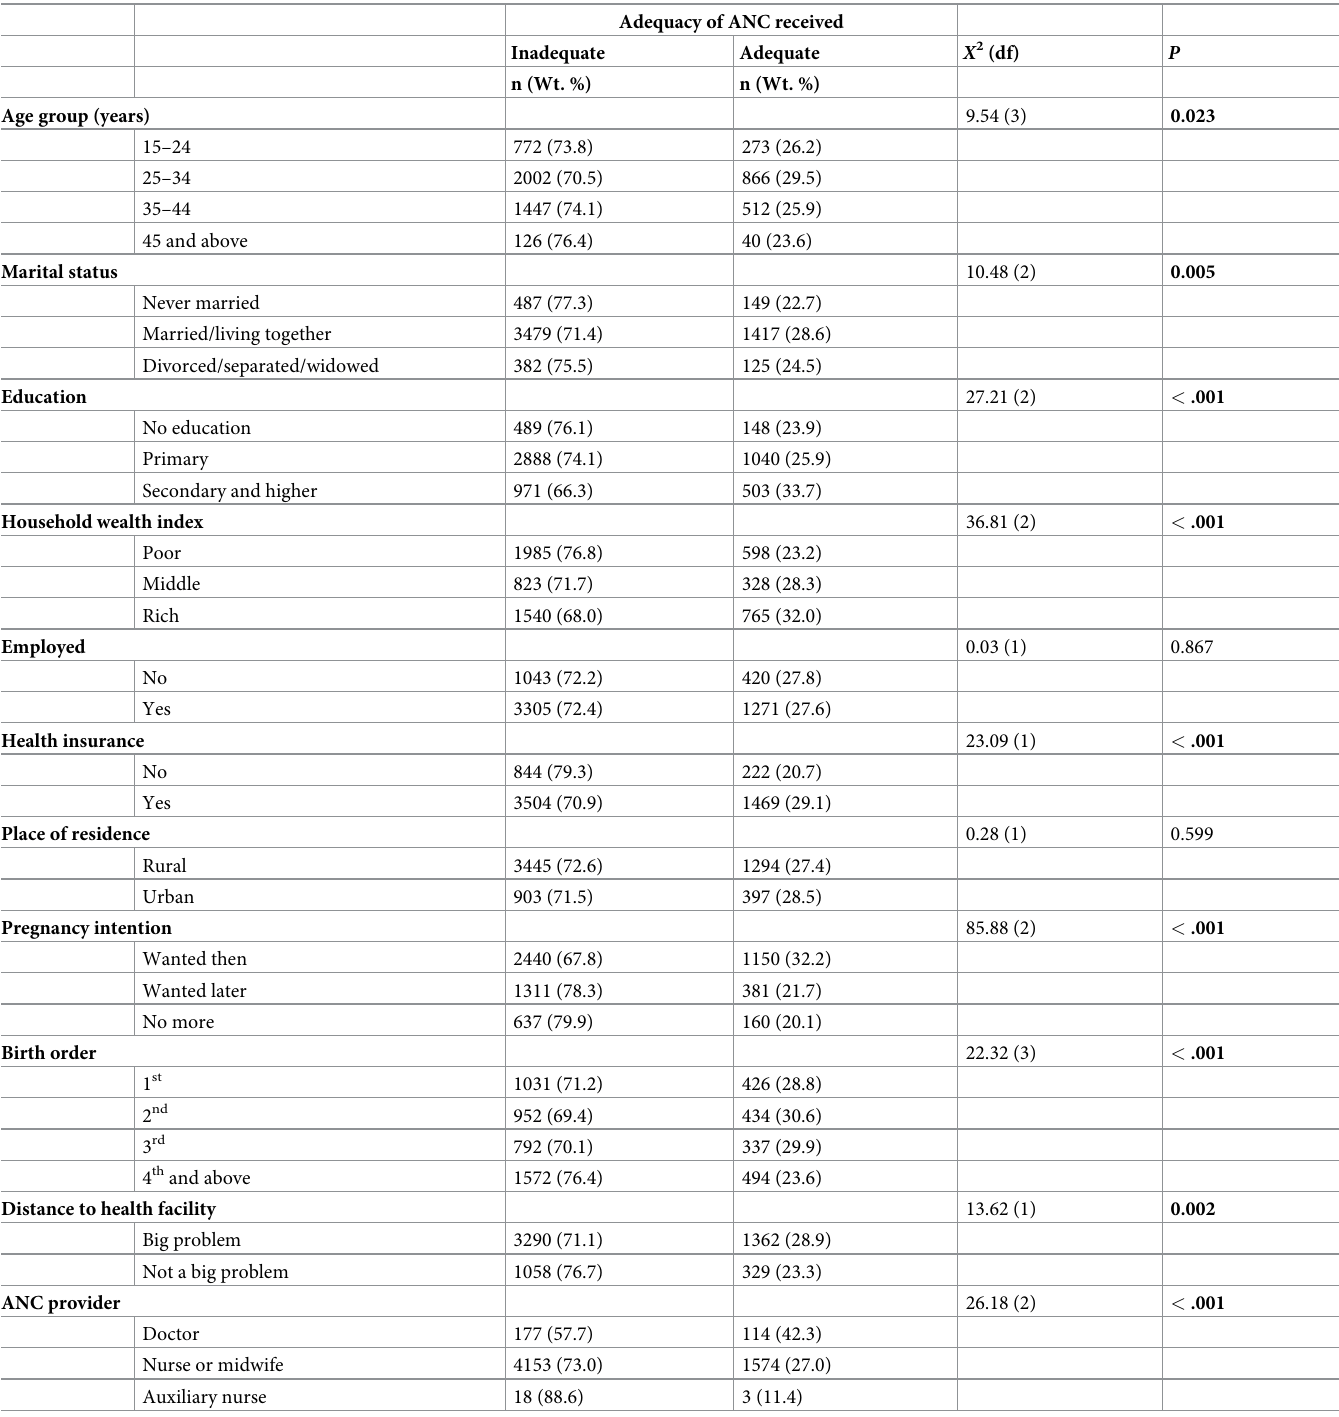
Table 2. Characteristics of the study sample by adequacy of ANC received (n =